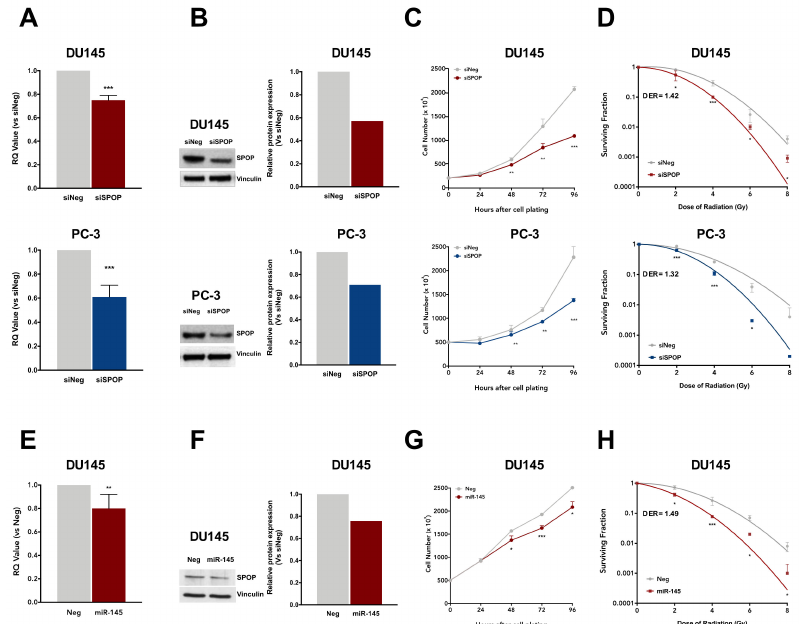
Figure 5. SPOP knockdown, through siRNA-SPOP (siSPOP) or miR-145 transfection, enhances cell response to radiation. ( A ) qRT-PCR detection of SPOP transcript levels in DU145 (upper panel) or PC-3 (lower panel) at 48 h upon transfection with siSPOP, compared to control cells, normalized to GAPDH. Data are reported as relative quantity (RQ) ± SD with respect to siNeg transfectants. ( B ) Western blot analysis and relative quantification of SPOP protein levels in DU145 and PC-3 cells at 48 h upon siSPOP transfection. Vinculin was used as endogenous control. ( C ) Cell proliferation curves of siNeg and siSPOP at 24, 48, 72 and 96 h upon transfection. Data are indicated as number of cells × 10 3 and are reported as mean ± SD values ( n = 3). ( D ) Clonogenic cell survival of DU145 and PC-3 cells upon transfection with siNeg or siSPOP. The surviving fractions are reported as mean ± SD values from three independent experiments. The dose enhancement ratio (DER) was calculated as the dose (Gy) for the radiation plus siSPOP divided by the dose (Gy) for radiation plus siNeg at a surviving fraction of 0.1. ( E ) qRT-PCR detection of SPOP transcript levels in DU145 cells at 48 h upon transfection with miR-145, compared to control cells, normalized to GAPDH. Data are reported as relative quantity (RQ) ± SD with respect to Neg cells. ( F ) Western blot analysis and relative quantification of SPOP protein levels in DU145 cells at 48 h upon miR-145 transfection. Vinculin was used as control. ( G ) Cell proliferation curves of Neg and miR-145 at 24, 48, 72 and 96 h upon transfection. Data are indicated as number of cells × 10 3 and are reported as mean ± SD values from three independent experiments. ( H ) Clonogenic cell survival of Neg or miR-145-transfected DU145 cells. The surviving fractions are reported as mean ± SD values from three independent experiments. The dose enhancement ratio (DER) was calculated as described above. The level of significance was represented as * p < 0.05, ** p < 0.01, *** p < 0.001, Student’s t